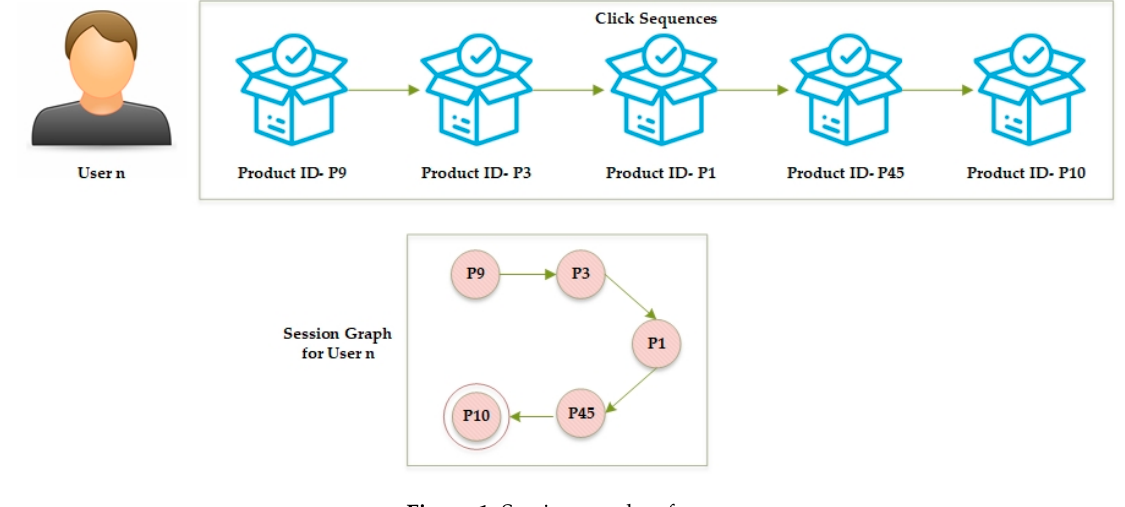
Figure 1. Session graphs of users.